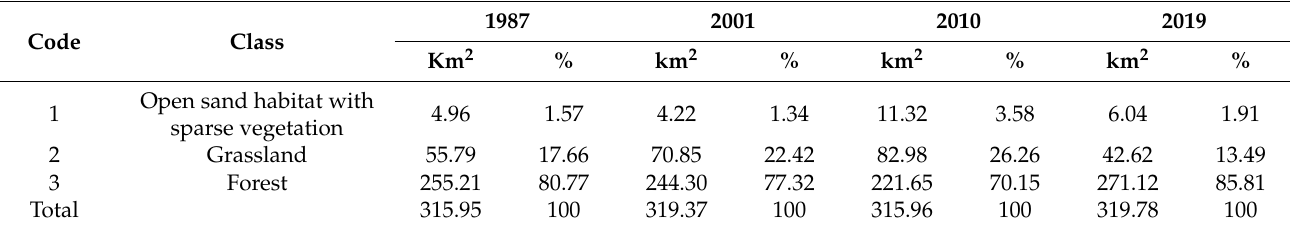
Figure 4. NDVI maps of the Hailar River from ( A ) 1987, ( B ) 2001, ( C ) 2010, and ( D ) 2019. Table 6. Areas of the study site (km 2 and percentages) based on NDVI